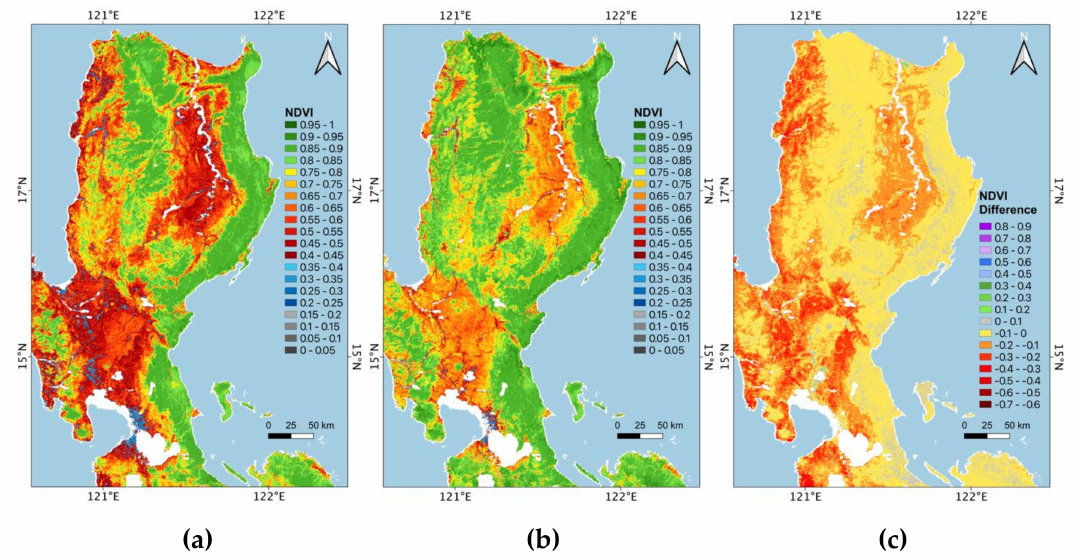
Figure 2. Normalized Di ff erence Vegetation Index (NDVI) climatological maps (2000–2017) as derived from the Moderate Resolution Imaging Spectroradiometer (MODIS) during ( a ) Dry season (March, April, May); ( b ) Wet Season (August, September, and October); and ( c ) Di ff erence between Dry and Wet